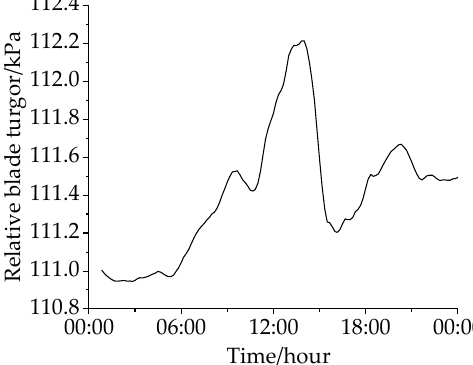
Figure 10. The turgor pressure curve under sufficient moisture.